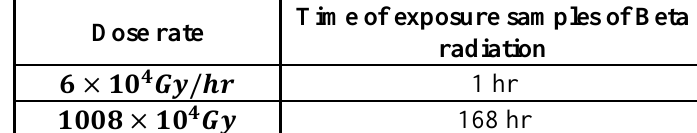
Table 1. The time of exposure to gamma rays and the doses of irradiation Beta particle. Dose